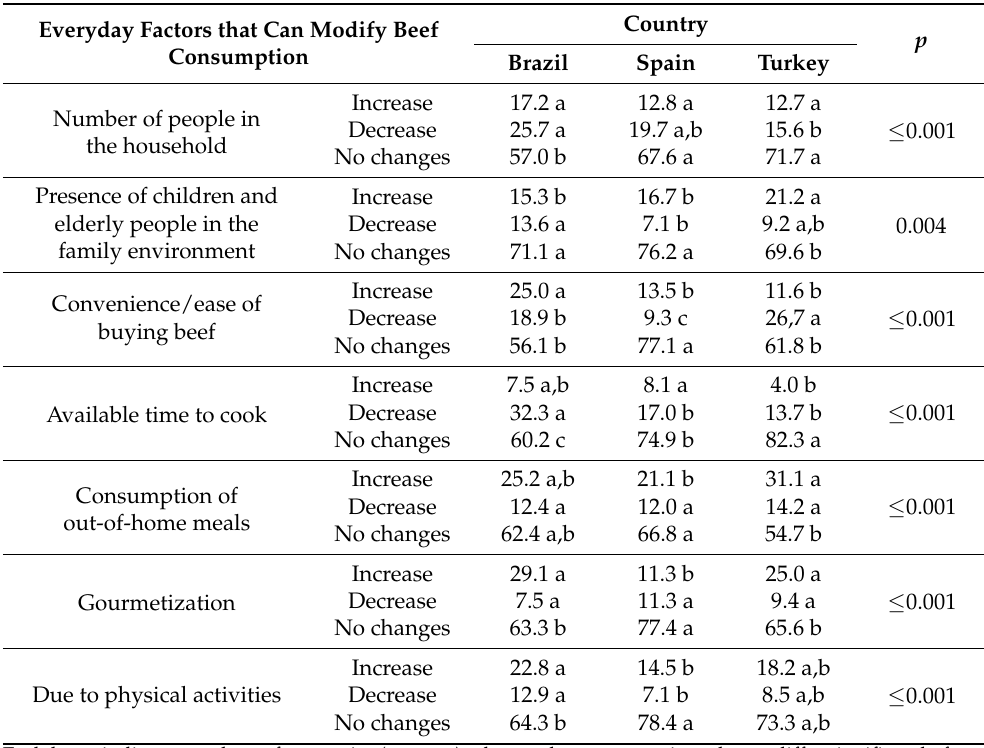
Table 8. Factors related to lifestyle that modify beef consumption by consumers in Brazil, Spain, and